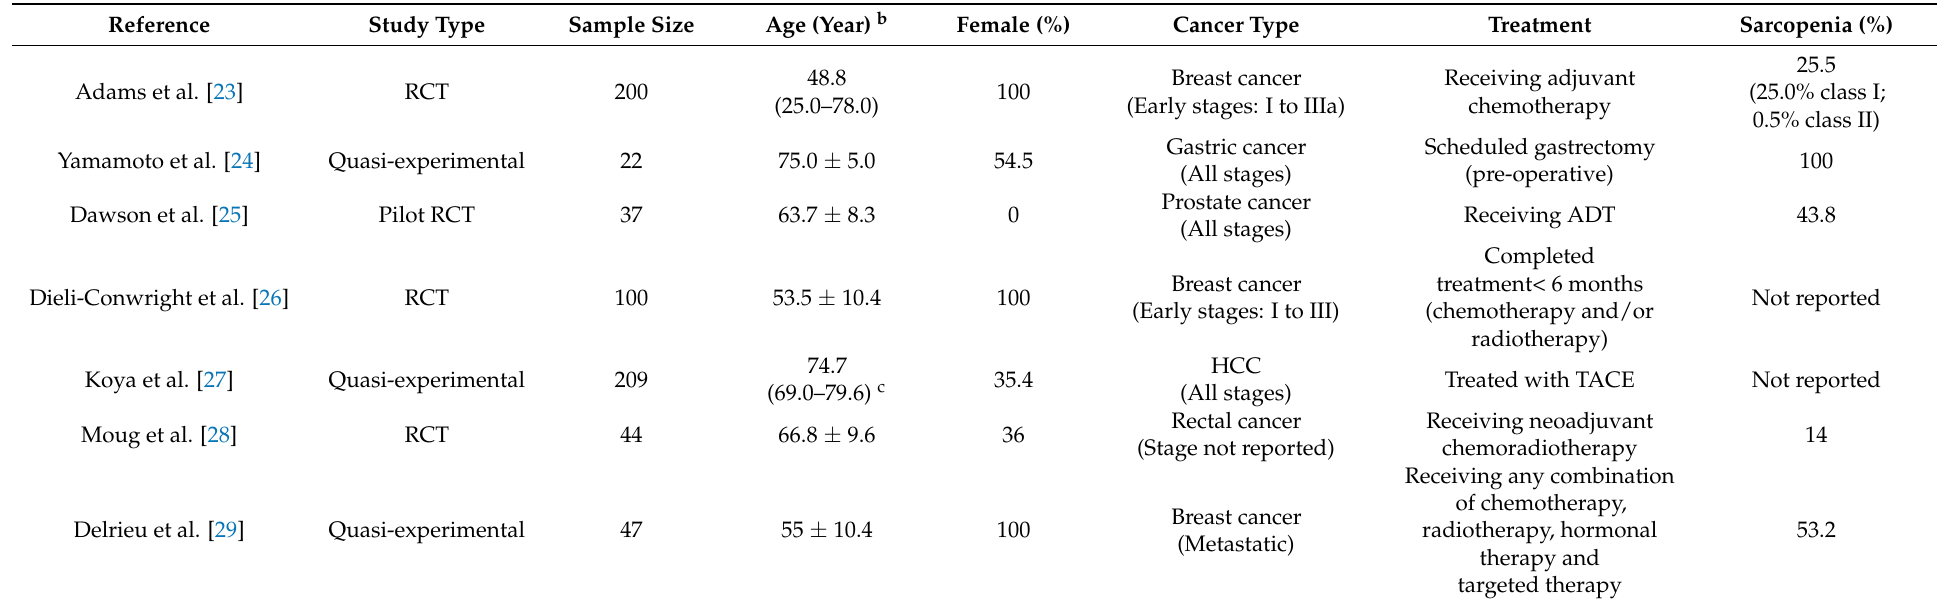
Table 2. Baseline characteristics of participants a